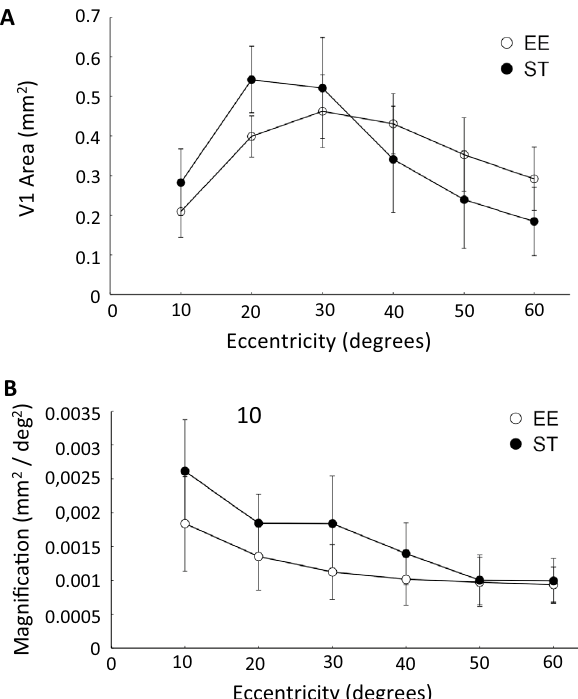
Figure 6. V1 organization per eccentricity of visual field in standard mice and mice reared in an enriched environment. ( A ) V1 area allocated for each range of eccentricity in both populations. There was an effect by eccentricity and by group, when performing repeated measures ANOVA (p < 0.001 for both). ( B ) Cortical magnification for each range of eccentricity in both populations. There was an effect by eccentricity and by group, when performing repeated measures ANOVA (p < 0.001 for the former, p = 0.011 for the latter). Data are presented as average ± SEM. Black filled circle: ST mice (n = 12); white filled circle: EE mice (n =